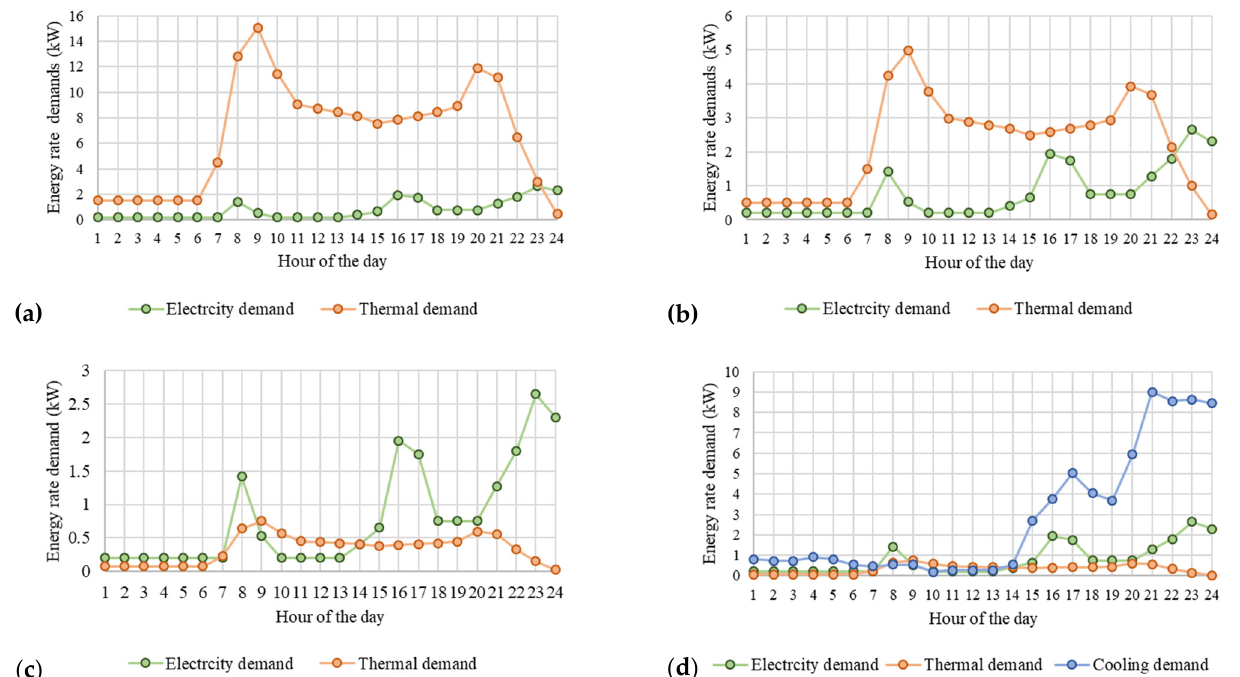
Figure 3. Hourly energy demand profiles for ( a ) a representative cold season day; ( b ) a representative cold mid-season day; ( c ) a representative hot mid-season day; and ( d ) a representative hot season day.